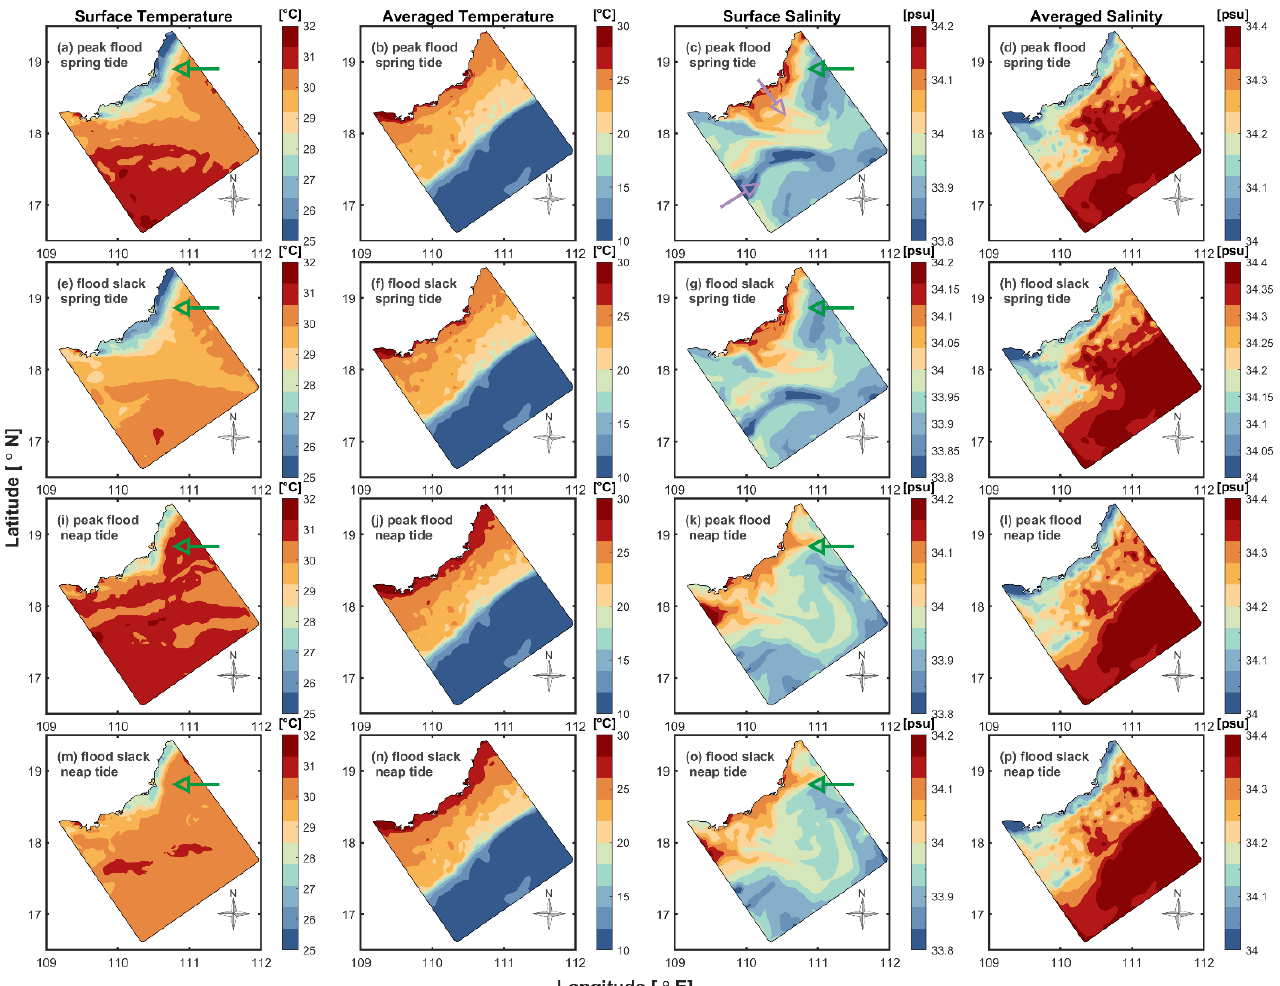
Figure 6. Temperature and salinity field at different times. ( a – d ) Peak flood of the spring tide. ( e – h ) Flood slack of the spring tide. ( i – l ) Peak flood of the neap tide. ( m – p ) Flood slack of the neap tide. The columns represent SST ( a , e , i , m ), vertically averaged temperature ( b , f , j , n ), SSS ( c , g , k , o ), and vertically averaged salinity ( d , h , l , p ).